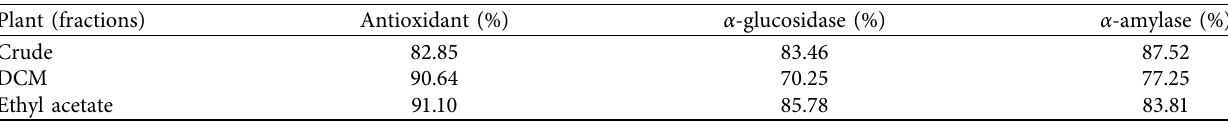
Table 1: Inhibition percentage (%) of the crude extract, EA, and DCM fractions of Erythropalum scandens against DPPH free radical, α -glucosidase, and α -amylase at 500 μ g/mL. Plant